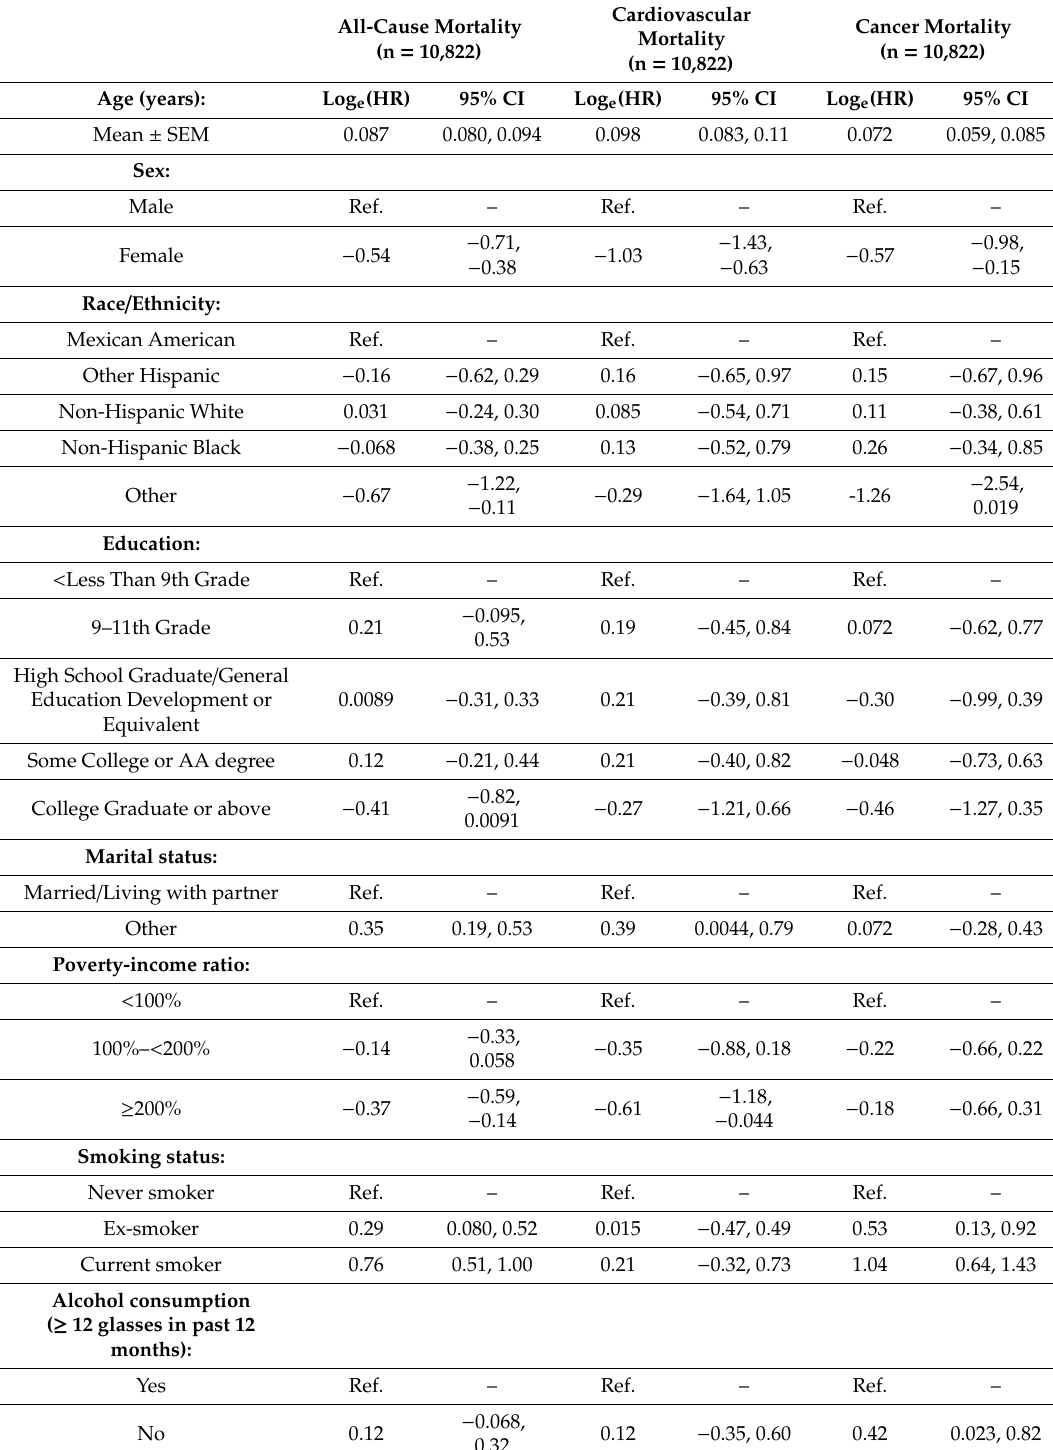
Table 2. Cox Proportional Hazards Models for Demographic, Socioeconomic, Lifestyle, and Health Characteristics as Predictors of All-Cause and Cause-Specific Mortality—2001–2010 NHANES (n = 10,822)